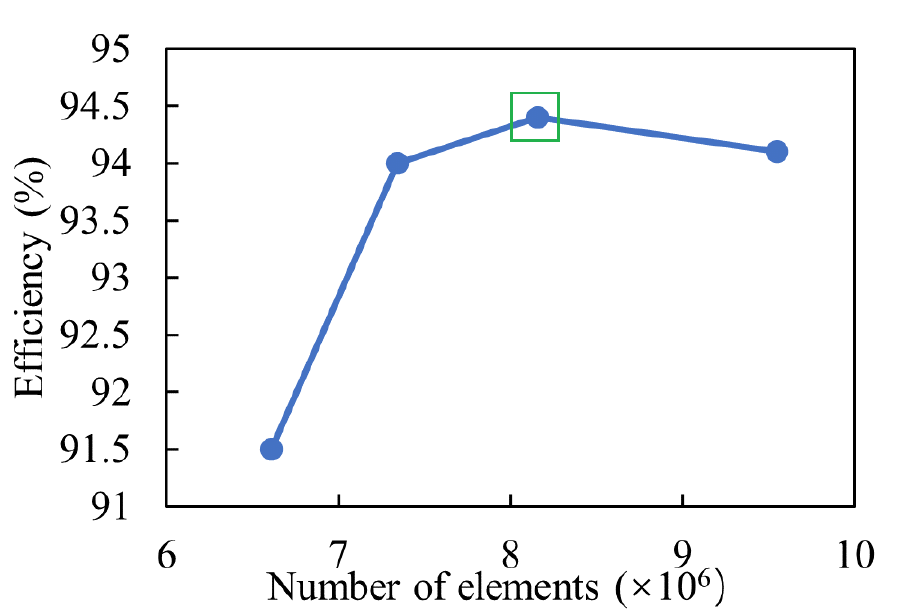
Figure 6. The mesh independence test of the CFD